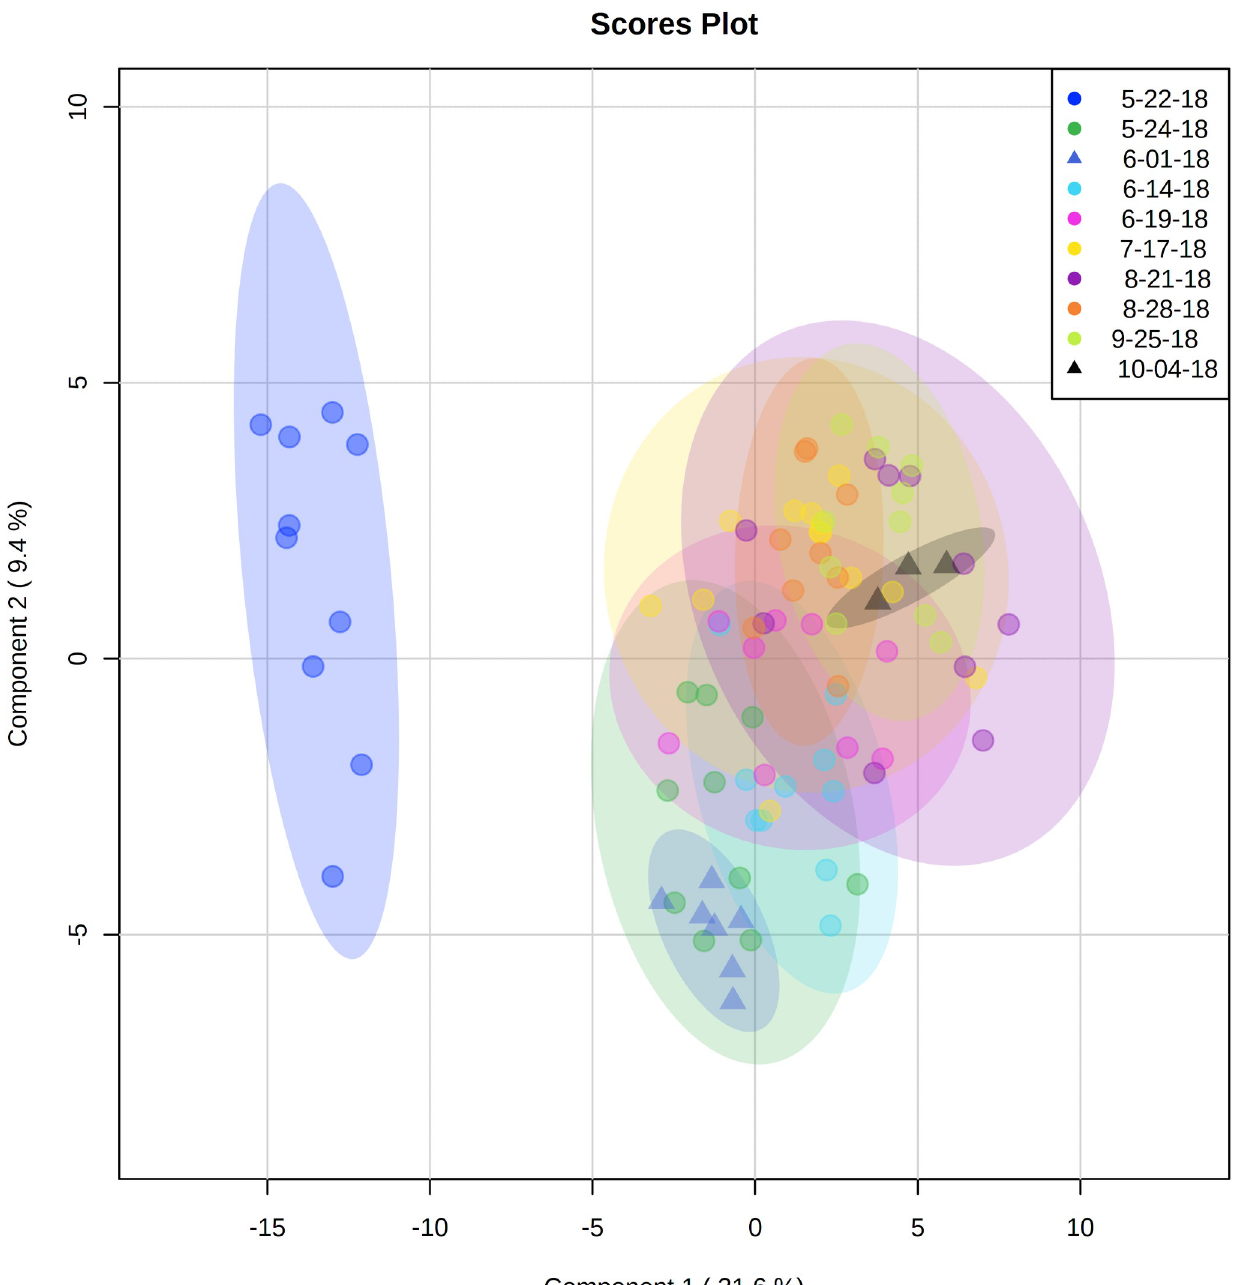
Fig 2. Temporal separation of metabolites in the livers of Bigheaded carp collected from the Illinois river. The legend color denotes the collection date between May and November 2018 and the shape indicates the collection area (upstream/downstream). https://doi.org/10.1371/journal.pone.0258150.g002 edge relative to conspecifics from downstream is not fully understood, but may in part be due to the type of contaminant(s) to which organisms are exposed [91], or food available [92], and should be investigated in future work. Together, results from this study clearly show that silver carp at the leading edge of the Illinois River have reduced levels of EPA relative